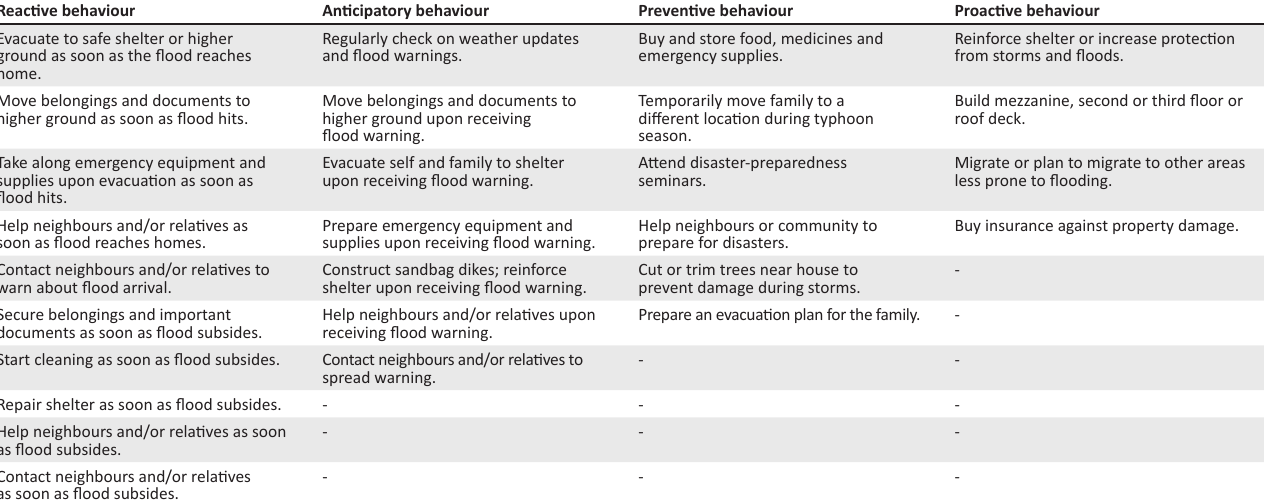
TABLE 2: Reactive, anticipatory, preventive and proactive measures. Reactive behaviour Anticipatory